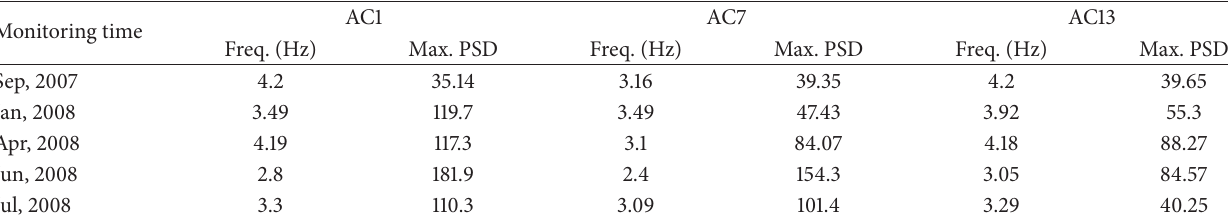
Table 2: Lomb-Scargle frequencies and power